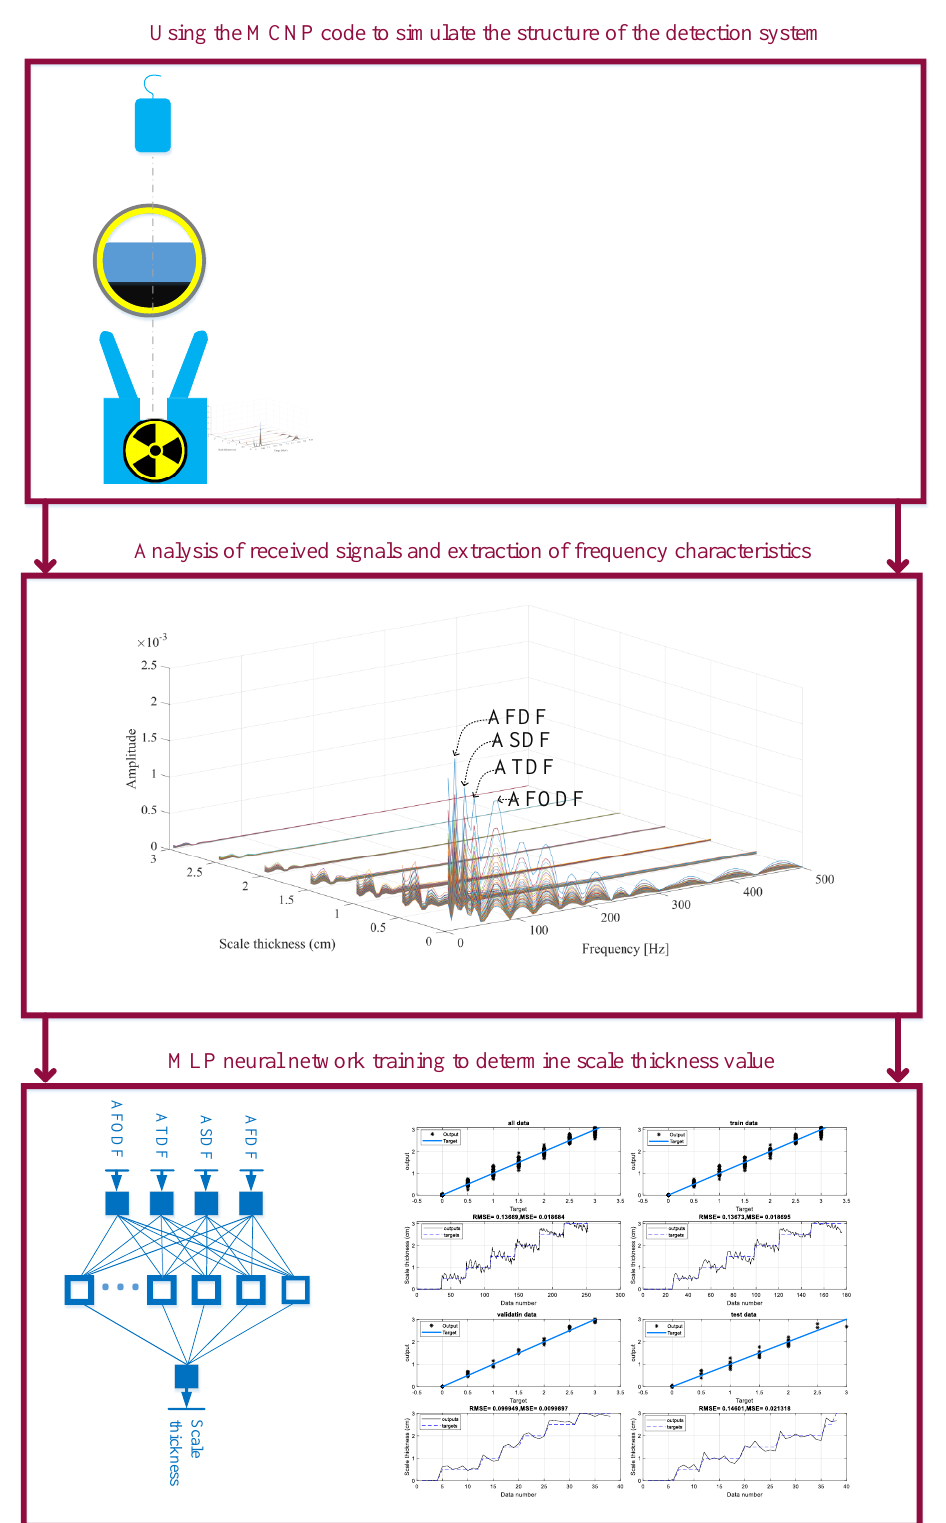
Figure 6. The overall tendencies of the proposed methods for measuring scale inside the pipe.